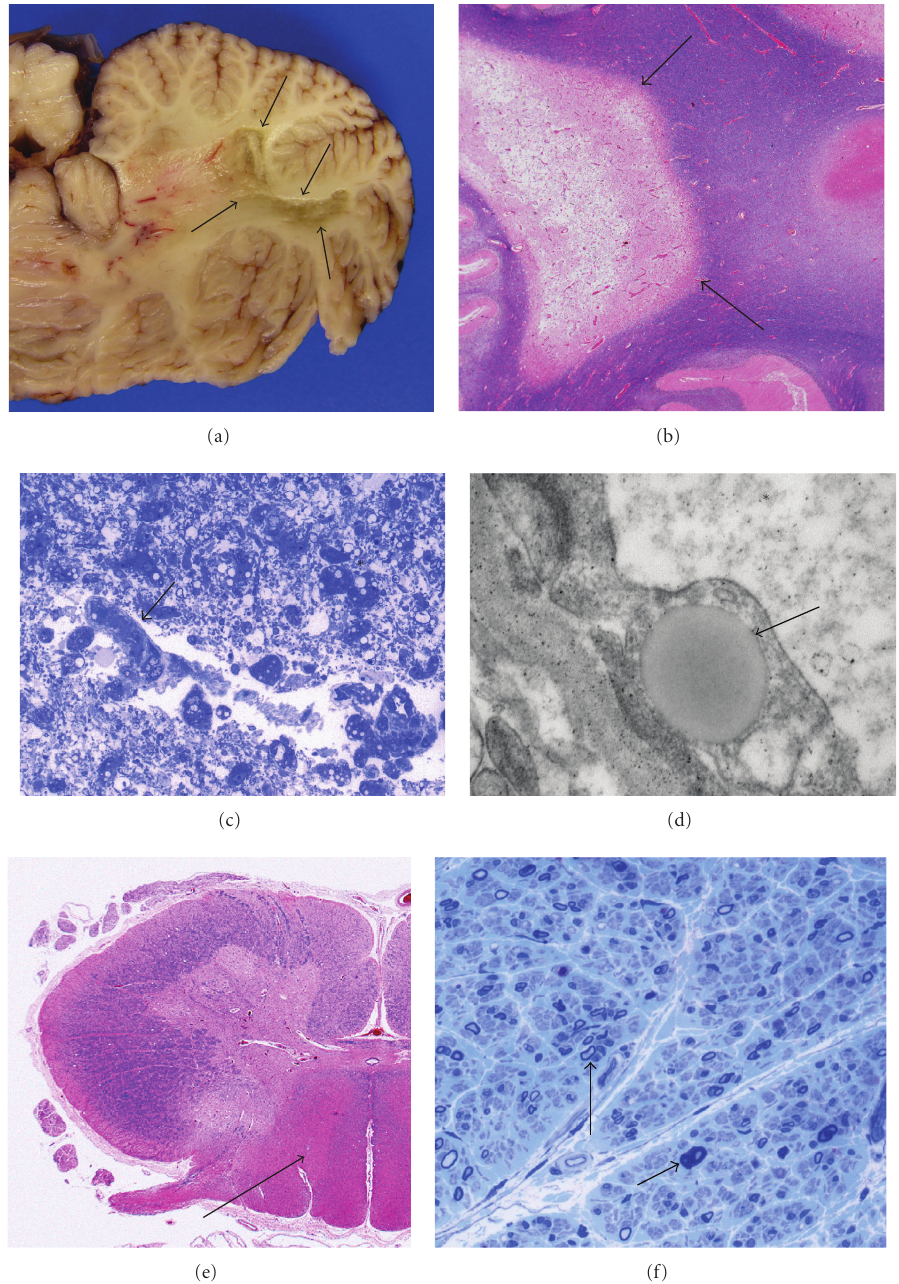
Figure 2: Pathologic findings. (a) Photograph of horizontal slice through right cerebellum and medulla showing irregular region of atrophy (arrows) in white matter lateral to the dentate nucleus. (b) Photomicrograph of cerebellum showing regional loss of myelin surrounding a cavity (arrows). (Solochrome cyanin/eosin stain; original magnification 12.5x.) (c) Photomicrograph of plastic-embedded sample of cerebellar lesion showing hypertrophic endothelium (arrow) and macrophages ( ∗ ) with vacuolated cytoplasm. (Toluidine blue stain; original magnification 600x.) (d) Electron micrograph of capillary endothelium ( ∗ shows lumen) in frontal lobe showing lipid droplet (arrow) (original magnification 80000x). (e) Photomicrograph of spinal cord showing loss of myelin staining and atrophy of posterior columns (arrow). (Solochrome cyanin/eosin stain; original magnification 12.5x.) (f) Photomicrograph of plastic-embedded sample of sural nerve showing moderately severe loss of myelinated axons (residual axons appear as dark rings; arrows). (Toluidine blue stain; original magnification